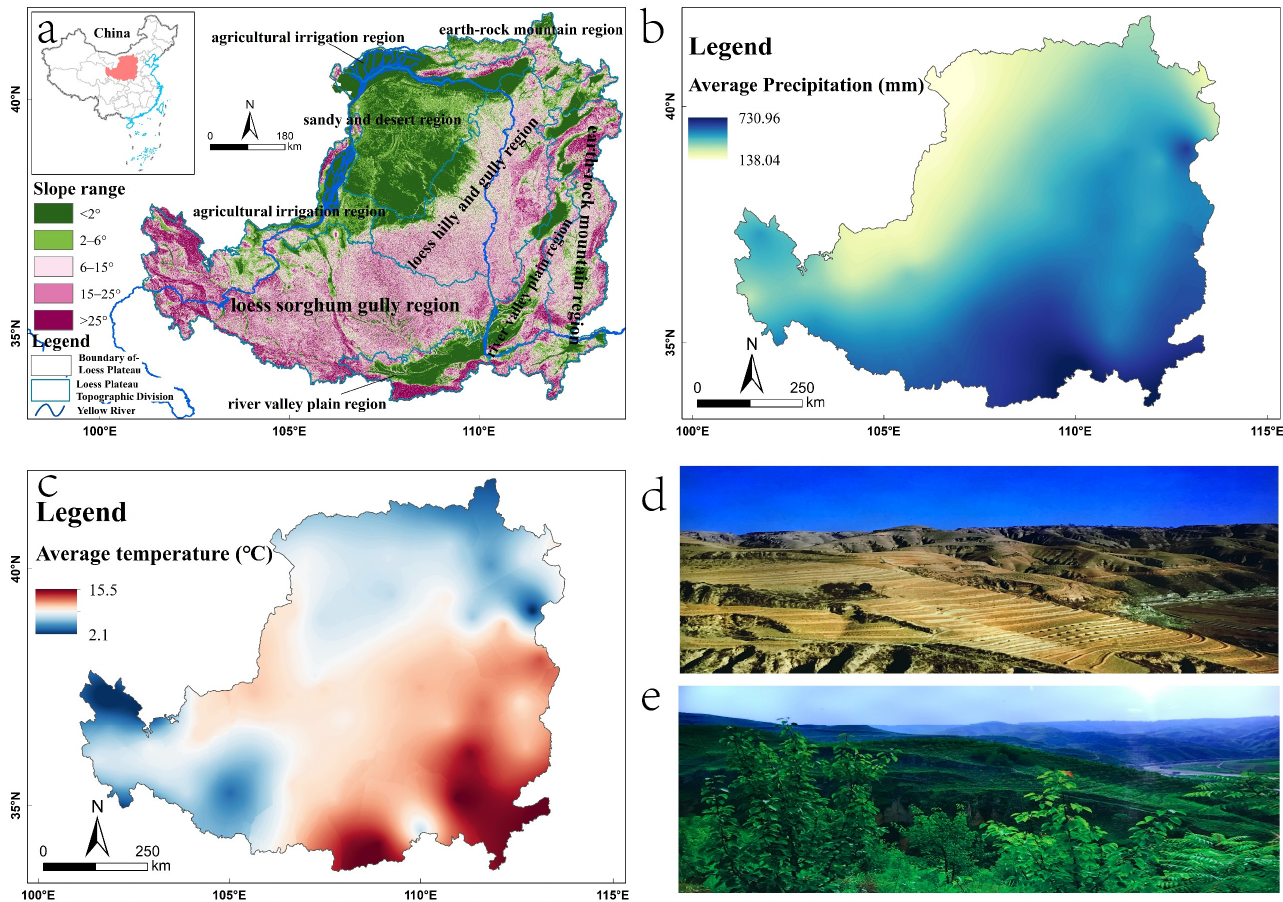
Figure 1. ( a ) Map of the Loess Plateau’s slope range and topographic division, ( b ) average precipi- tation distribution on the Loess Plateau from 2000 to 2018; ( c ) average temperature distribution across the Loess Plateau from 2000 to 2018; ( d ) Loess Plateau before the implementation of the SLCP; ( e ) Loess Plateau after the implementation of the SLCP.